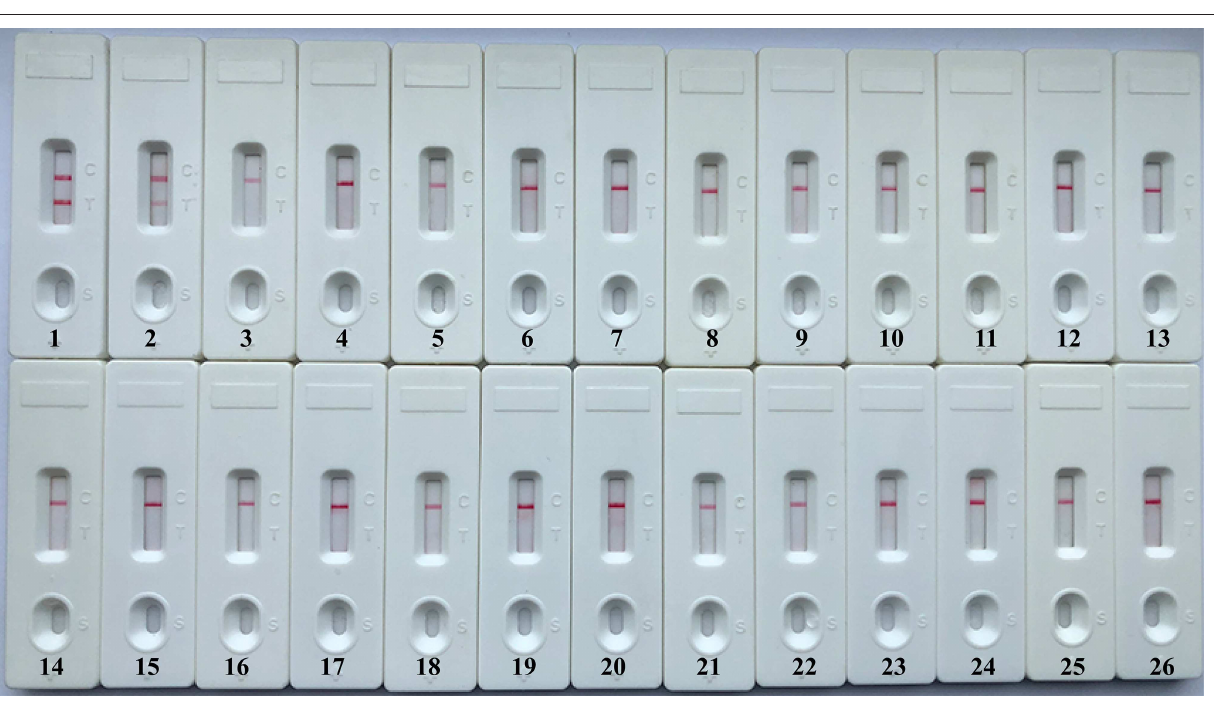
antibody, which is immobilized at the TL of the biosensor. The biotin tags, which are incorporated into PSR amplicons labeled using biotin-14-dCTP and biotin-14-dATP, are capable